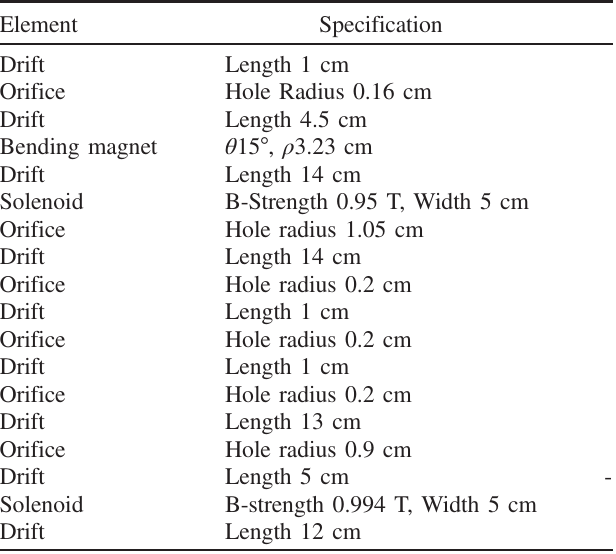
TABLE III. LEBT design for proton acceleration. The charge neutralization effect was assumed to be 90% during LEBT transportation. The symbols θ and ρ represent the bend angle and curvature radius for the bending magnet, respectively.